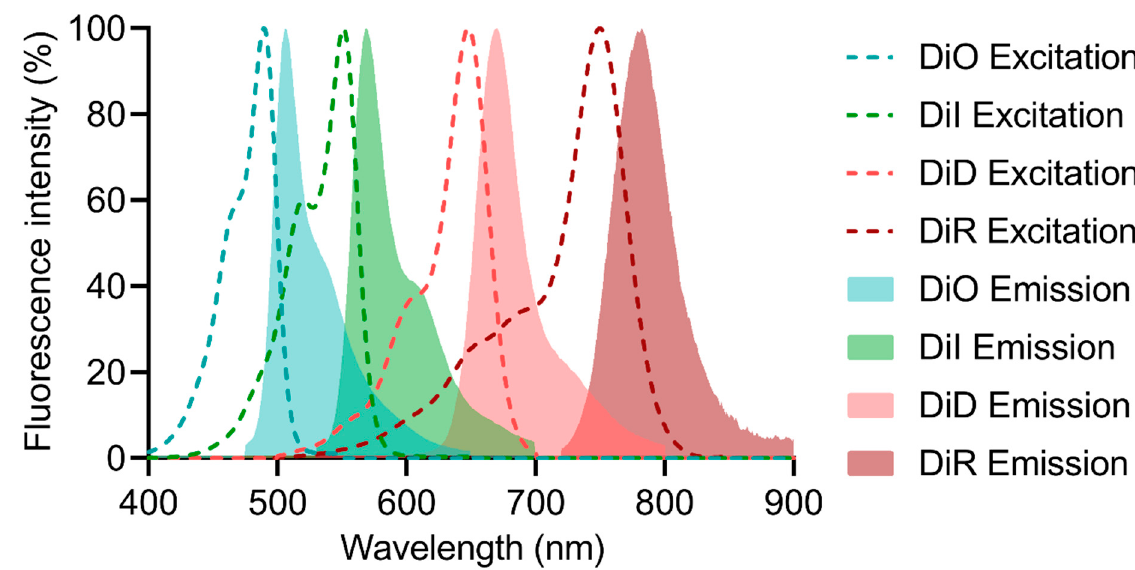
Figure 1. Fluorescence spectra of lipophilic tracer dyes.